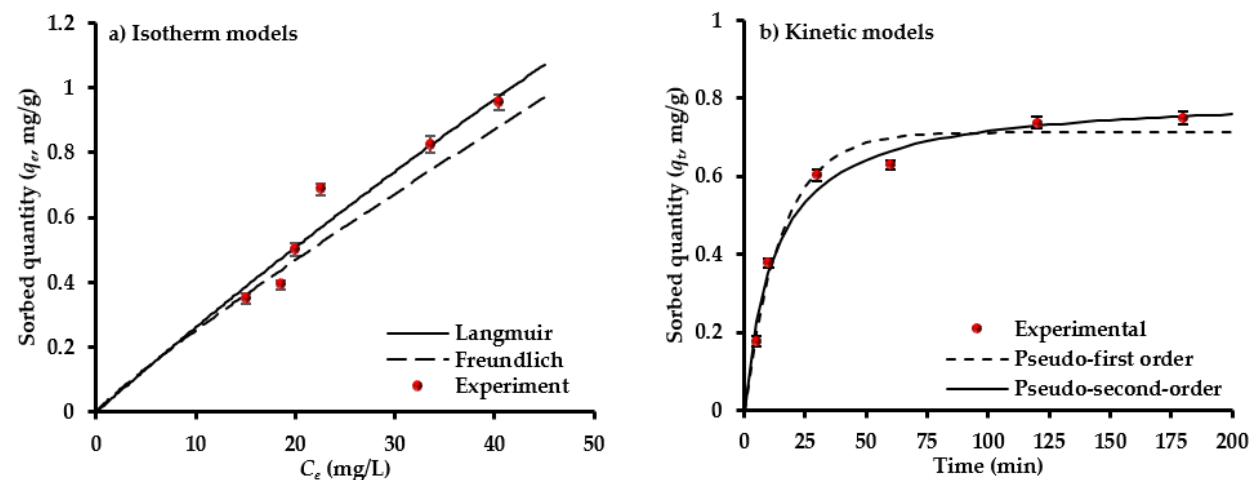
Figure 3. Sorption isotherms ( a ) and kinetics models ( b ) for the interaction of composite sorbent and solution containing SO 42 − ions.